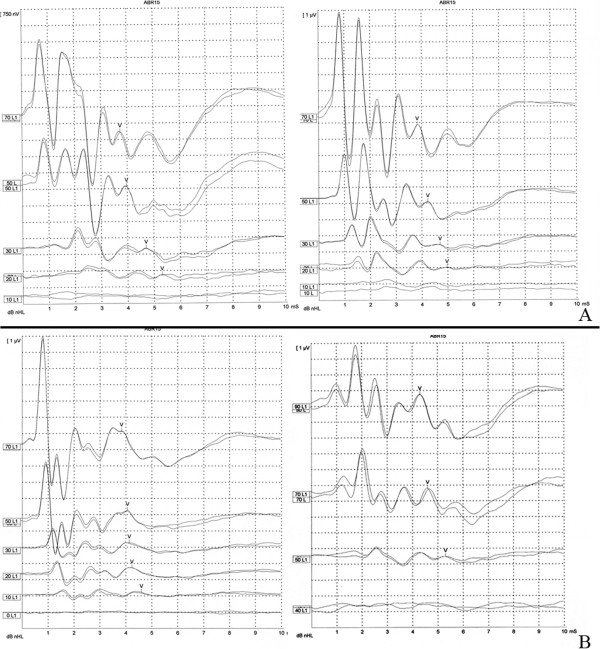
Graphs demonstrating two examples of ABR thresholds before and after terbinafine solution (A) and gentamicin solution (B). There were no statistically significant differences in ABR thresholds before and after terbinafine solution (p > 0.05). However; ABR thresholds were significantly increased, after gentamicin application (p < 0.05).